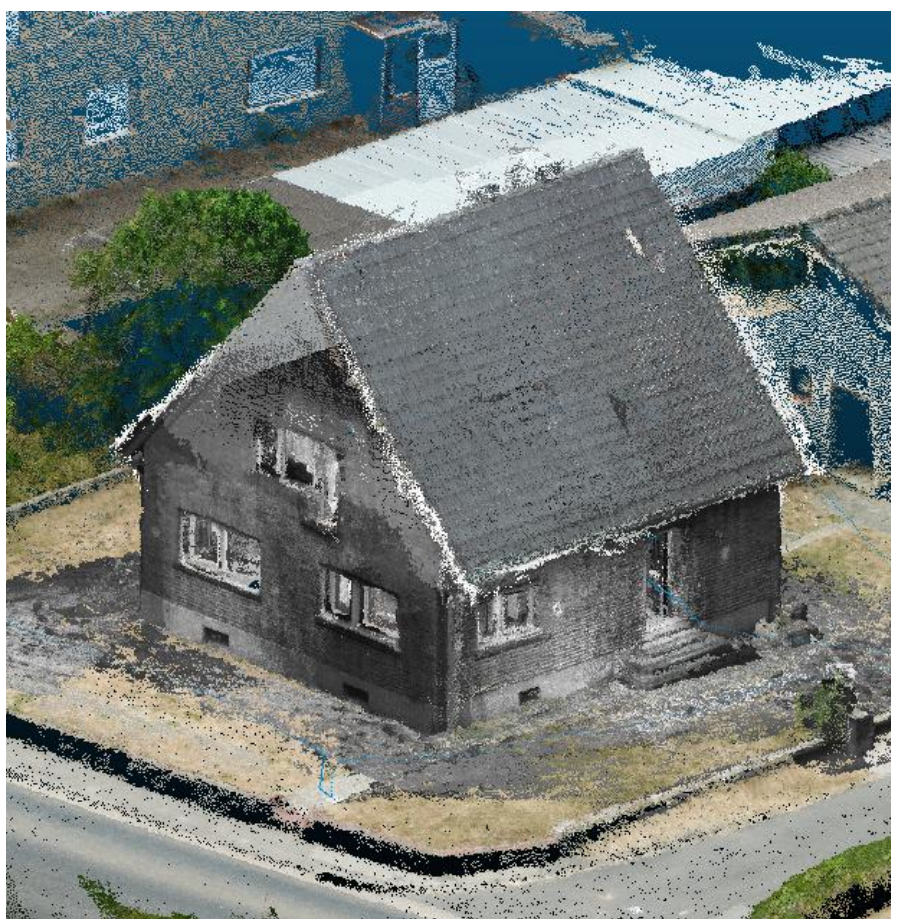
Figure 10. Complementary 3D reconstruction from UAV imagery (colored parts inclusive of the gray roof) combined with IPS on-ground derived point cloud (ground surroundings and building walls shown in